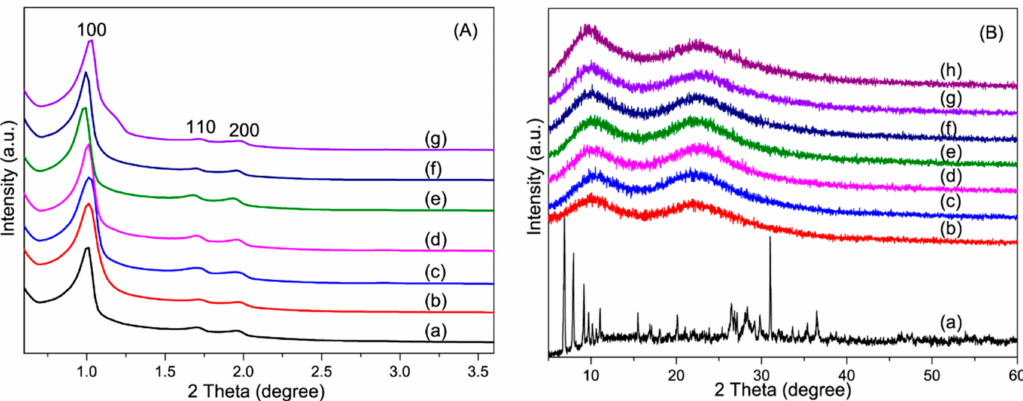
Figure 2. ( A ) Small-angle XRD patterns of (a) SBA-15, (b) NH 2 -SBA-15, (c) 3.3PMo / NH 2 -SBA-15, (d) 6.7PMo / NH 2 -SBA-15, (e) 10PMo / NH 2 -SBA-15, (f) 13.3PMo / NH 2 -SBA-15, and (g) 16.7PMo / NH 2 -SBA-15; ( B ) Wide-angle XRD patterns of (a) H 3 PMo 12 O 40 · nH 2 O, (b) SBA-15, (c) NH 2 -SBA-15, (d) 3.3PMo / NH 2 -SBA-15, (e) 6.7PMo / NH 2 -SBA-15, (f) 10PMo / NH 2 -SBA-15, (g) 13.3PMo / NH 2 -SBA-15, and (h) 16.7PMo / NH 2